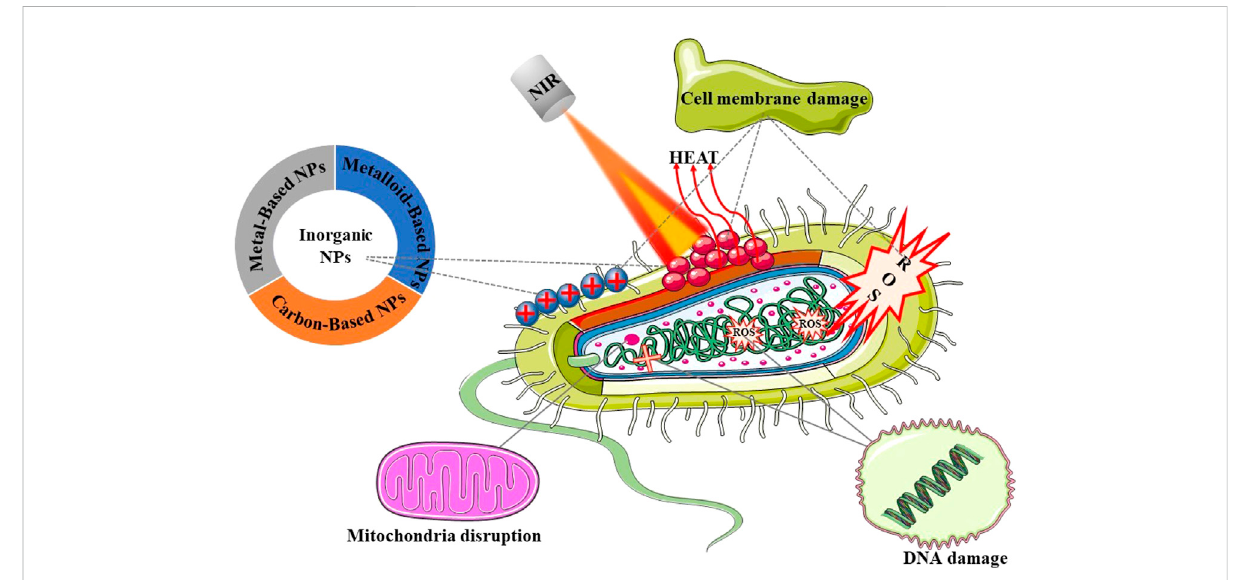
FIGURE 1 Schematic illustration of the main topics covered in this review.